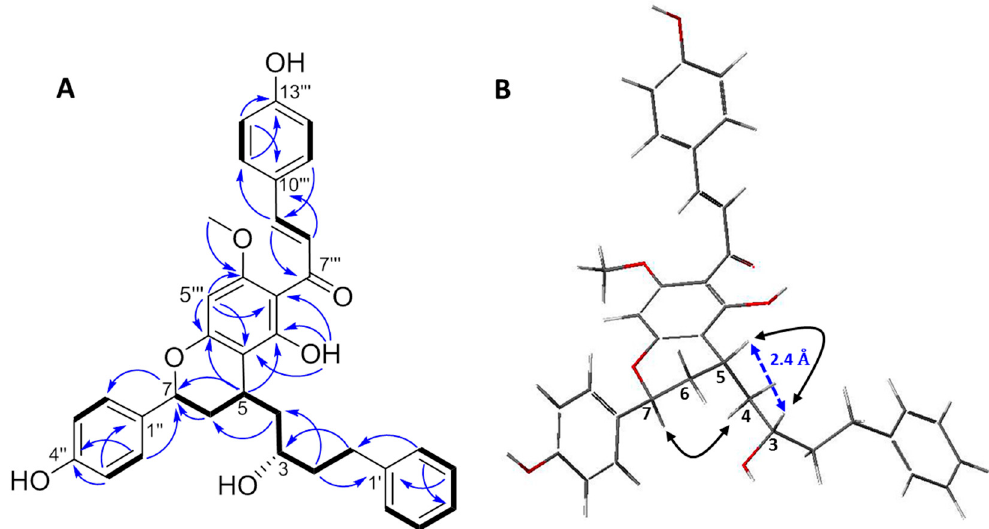
Figure 2. ( A ) Key 1 H- 13 C HMBC ( → ), 1 H- 1 H COSY ( ▬ ), and ( B ) 1 H- 1 H NOESY ( ↔ ) correlations for compound 1 . B is the energy minimized stereostructure of 1 (MM3 calculation using the CAChe 5.0 TM molecular modeling program).